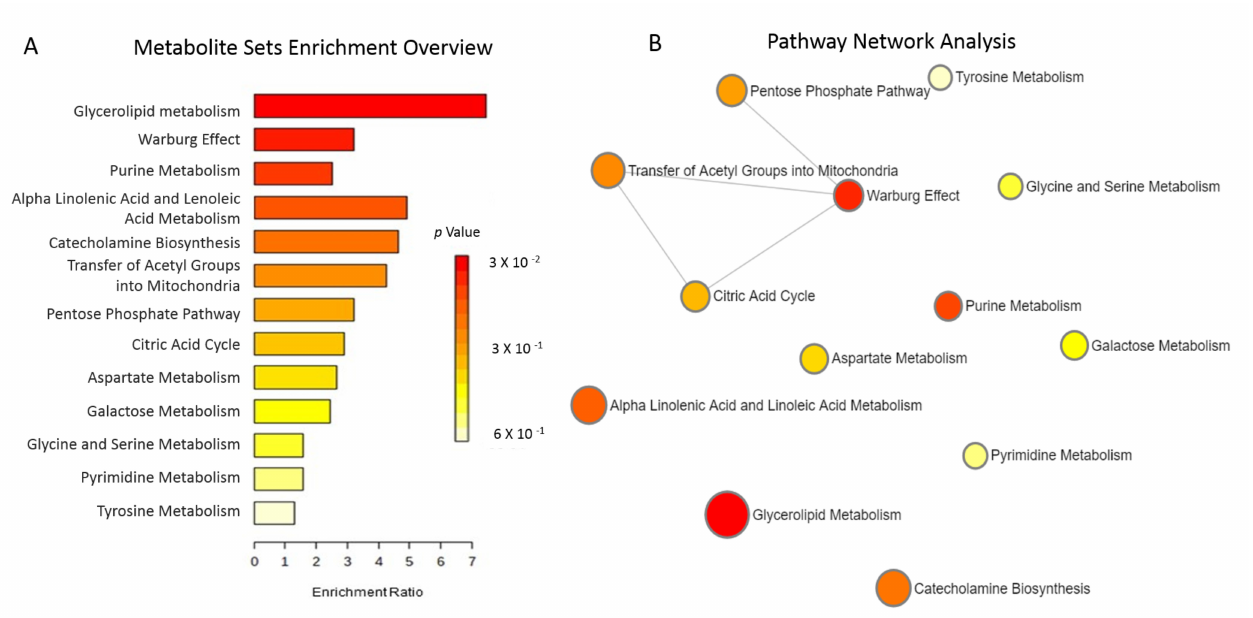
Figure 2. ( A ). Metabolites Sets Enrichment. Over-representation analysis including the metabolites most significantly altered by allopurinol is shown. This does not account for the direction of the change in the metabolites (increased vs. decreased). Bar colors reflect the significance ( p value) for the specific pathway. The length of each bar indicates fold enrichment of each metabolic pathway. ( B ). Metabolic Pathway Analysis highlights the significant pathways affected by allopurinol compared to placebo. We found limited overlap between the pathways affected by allopurinol. The matched pathways are shown as circles. The Y -axis represents the − log of p -values from pathway enrichment. The X -axis represents pathway impact value calculated from pathway topology analysis. The color and diameter of each circle is based on p -value and pathway impact value,